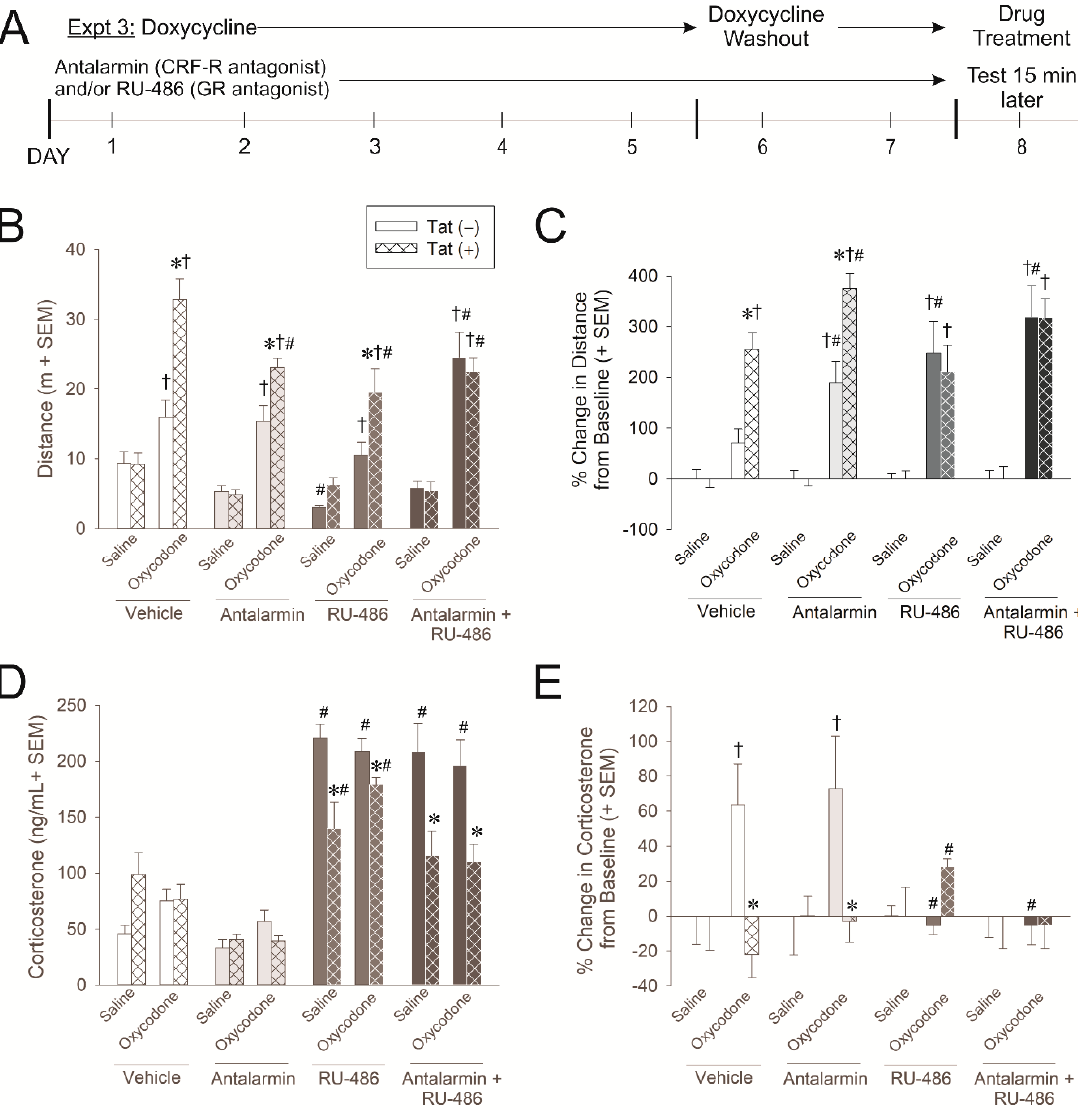
Figure 3. ( A ) In experiment 3, Tat( − ) (see open bars) and Tat(+) (see hatched bars) mice were administered antalarmin (corticotrophin-releasing factor receptor antagonist; 20 mg/kg, i.p. for 6 days) and/or RU-486 (glucocorticoid receptor antagonist; i.p., 20 mg/kg, i.p. for 7 days) concurrent with the induction of HIV-1 Tat via doxycycline (30 mg/kg, i.p., once daily for 5 days with 2 days of doxycycline washout). Mice were treated with the final dose of antalarmin and/or RU-486 and then challenged with saline or oxycodone (3 mg/kg, i.p.) and assessed in an open field and light-dark transition test ( n = 8–10/group). ( B ) Distance (m) traveled in an open field and ( C ) the proportional change from baseline in distance traveled in open field. ( D ) Circulating corticosterone and ( E ) the proportional change from baseline in circulating corticosterone. * indicates an interaction wherein Tat(+) mice differ from respective Tat( − ) controls. † indicates an interaction wherein oxycodone-administered mice differ from respective saline-administered controls. # indicates an interaction wherein the denoted group differs from their respective vehicle controls, p < 0.05.